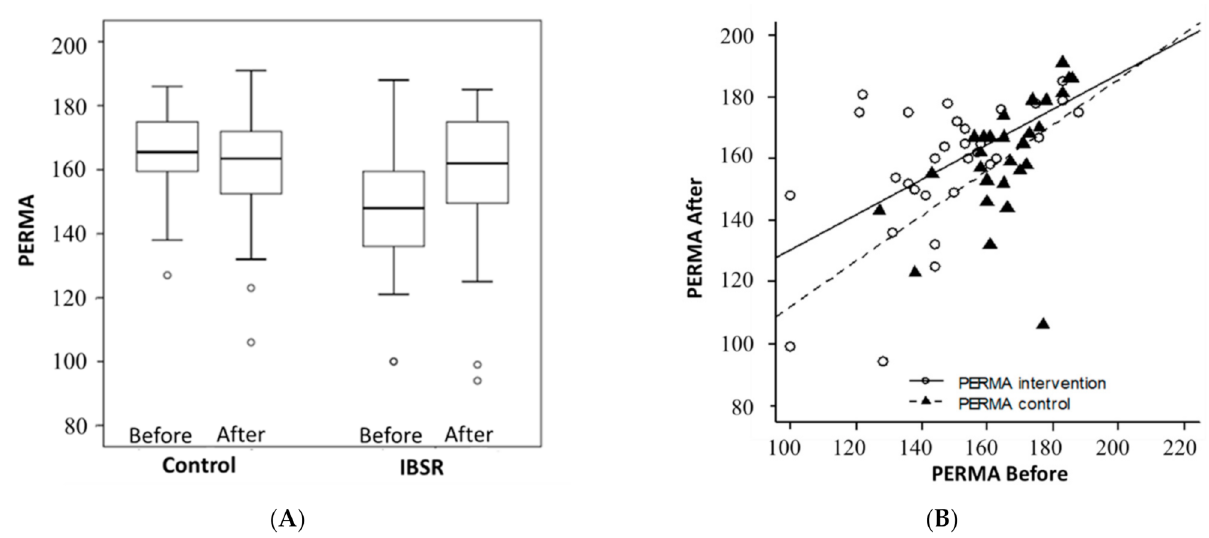
Figure 2. ( A ) . Effect of IBSR intervention on the psychological well-being (PERMA) in comparison to control group. Data is displayed as box plot of both groups. * p < 0.05. ( B ) . Relationship between the pre- and post-PERMA profiler for the two groups. Scatter plot analysis indicate that IBSR (solid line) was more effective than control (dashed line), especially for subjects with low initial PERMA